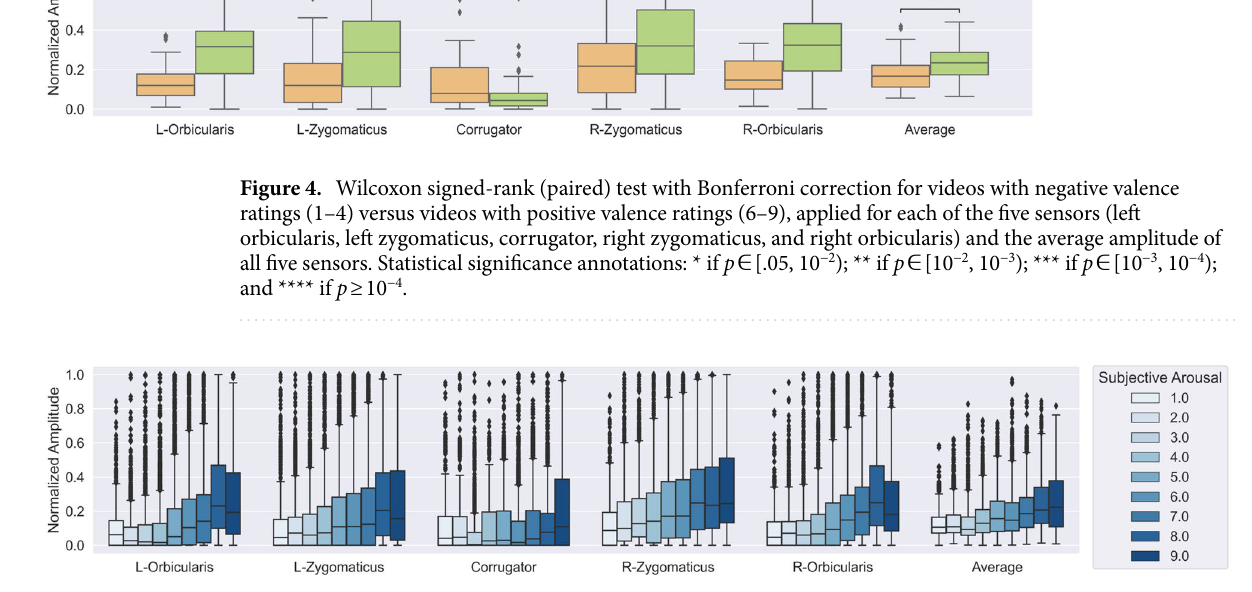
Figure 5. Boxplots representing the distribution of the normalized EMG amplitudes for the five EMG sensors (left orbicularis, left zygomaticus, corrugator, right zygomaticus, and right orbicularis) and their average amplitude, grouped by subjective arousal ratings from one (low arousal) to nine (high